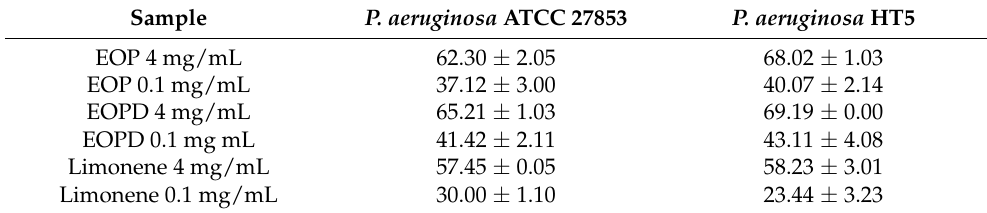
Table 4. Inhibition (%) of the production of the Pseudomonas aeruginosa virulence factor pyocyanin.